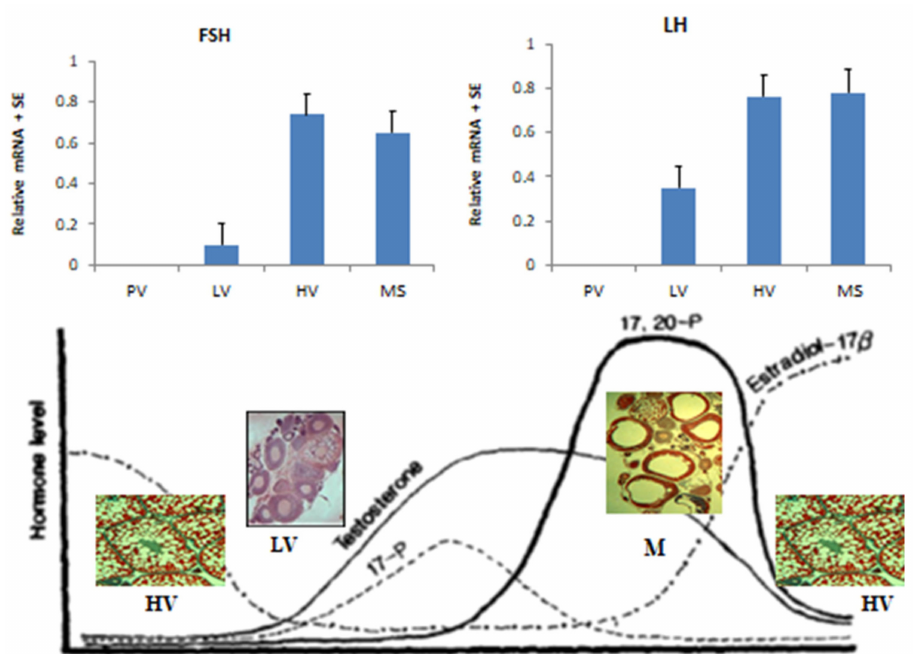
Figure 7. Proposed quality model showing the relationship between gonadotropins levels and steroids during the gonadal cycle, low vitellogenesis (LV), high vitellogenesis (HV), and maturation (MS). The steroids are 17 β -estradiol (E2), testosterone (T), 17 α ,20 β - dihydroxy-4-pregnen-3-one (17,20-P)